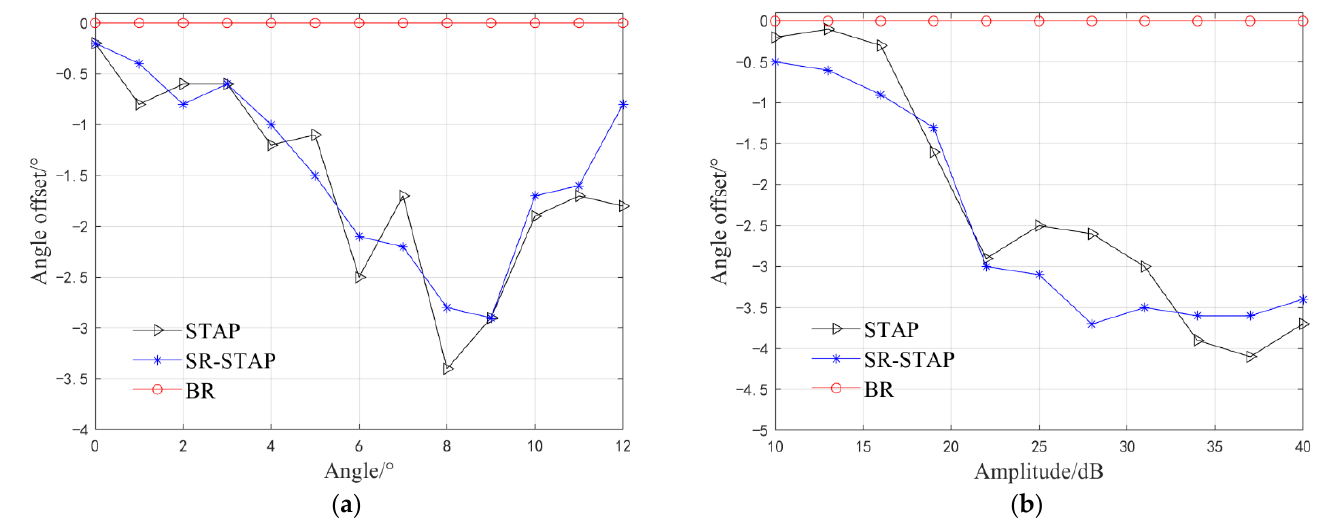
Figure 4. Result of the angle offset varying with ( a ) the energy of the main-lobe clutter and ( b ) the angle of the main-lobe clutter.